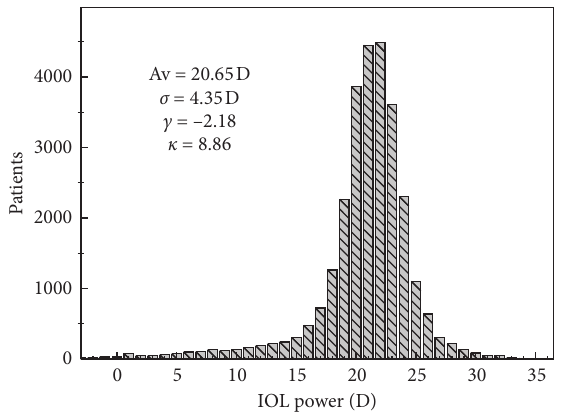
Figure 8: Histogram of the implanted lens power, with 1 D bin. In the inset, the values of the main statigraphs are